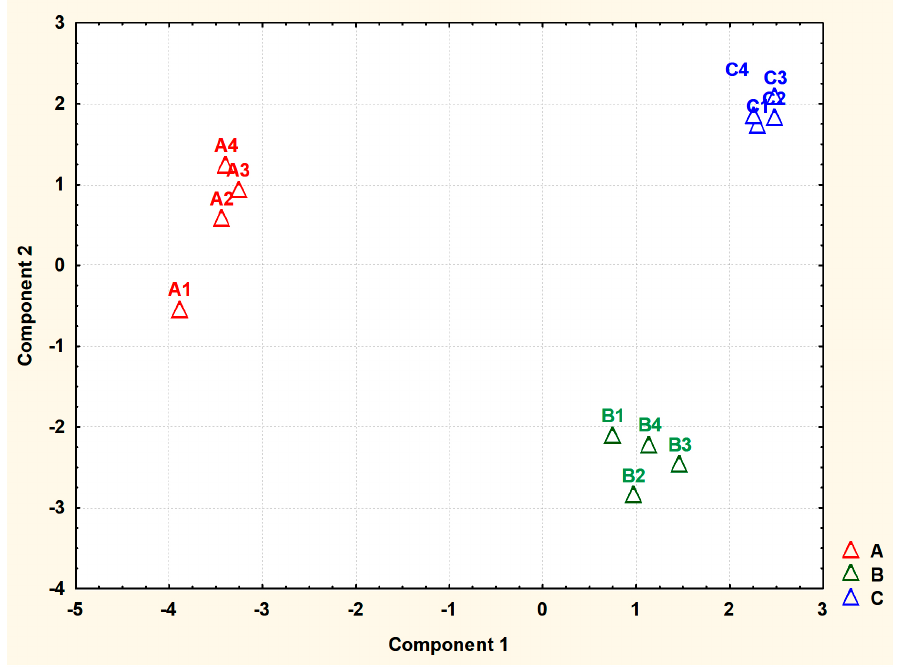
Fig. 4. Principal component analysis (PCA) scores (component1 versus component 2) plotted from cytoplasmic metabolite data of S. aureus . The S. aureus cultures were grown under (A1-A4) ideal conditions at pH7_37°C (control), pH6 at 35°C, (B1-B4) and pH8 at 35°C (C1-C4) to mid-exponential phase of growth before extraction of cytoplasmic metabolites and analysis by